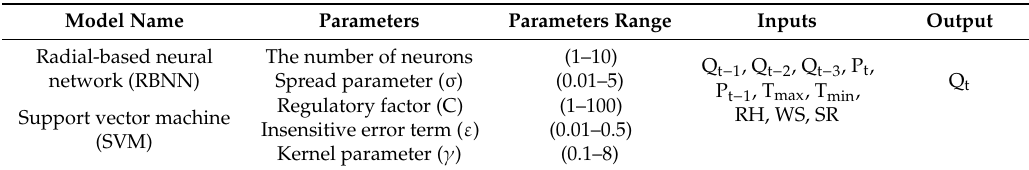
Table 4. The structures, inputs and outputs of AI